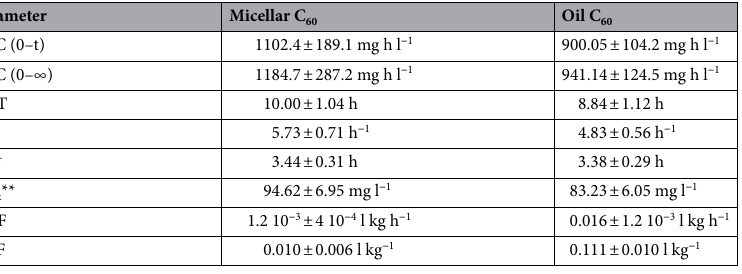
Table 4. PK parameters of micellar and oil dispersions of C 60 in conventional mice ( m = 25 g) after oral administration of C 60 in micellar and in oil forms ( n = 10). * t max is time of maximum plasma concentration. ** C max is maximum plasma